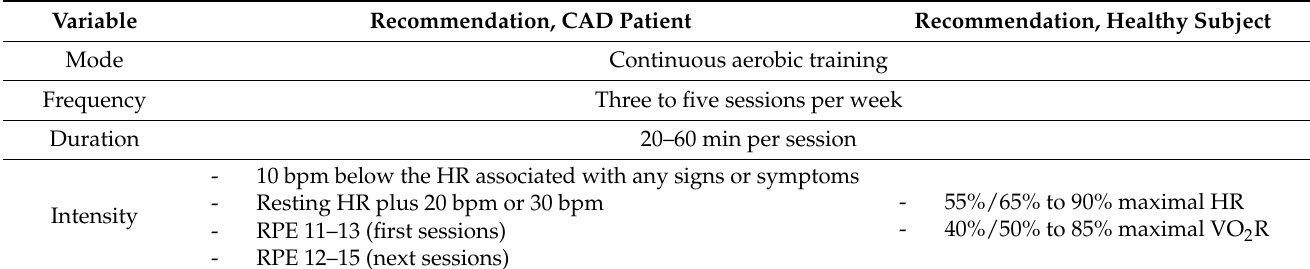
Table 4. Prescription of Aerobic training.